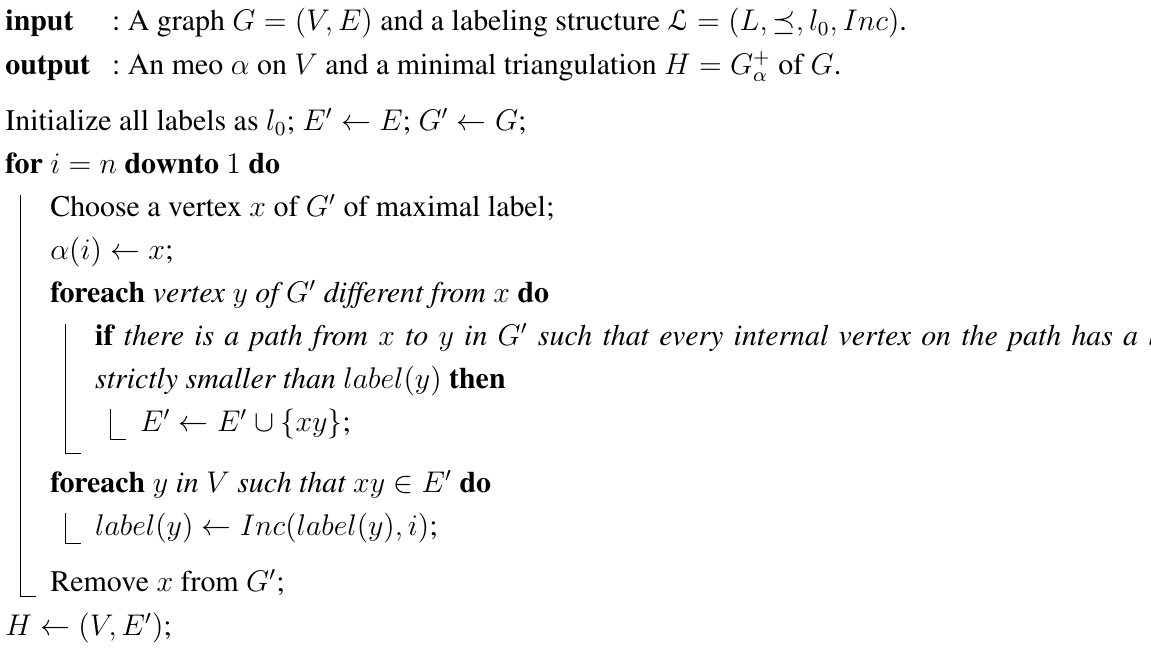
Algorithm MLSM (Maximal Label Search for